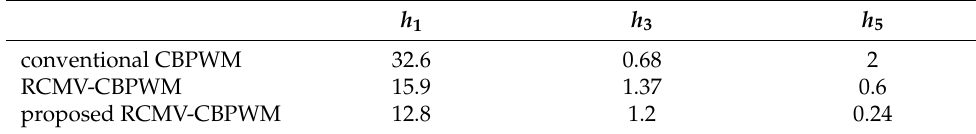
Table 6. Harmonic content of CMV for case